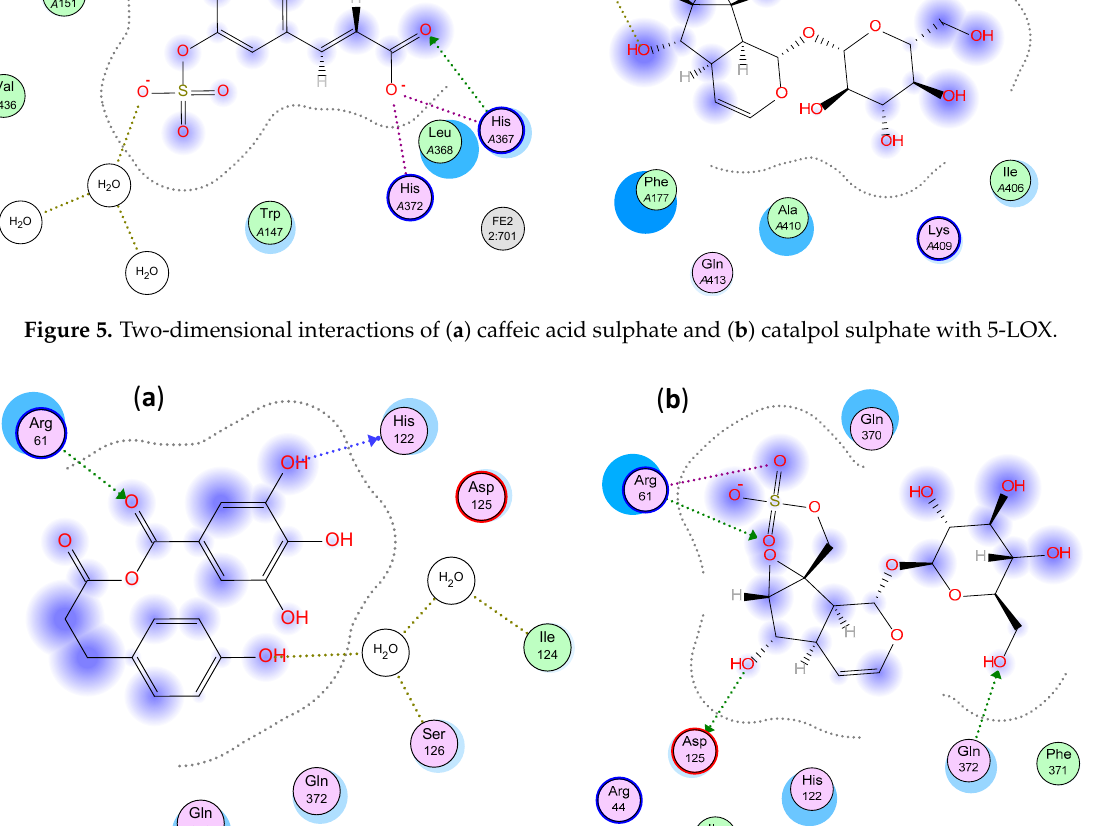
Molecules 2021 , 26 , x FOR PEER REVIEW 11 of 13